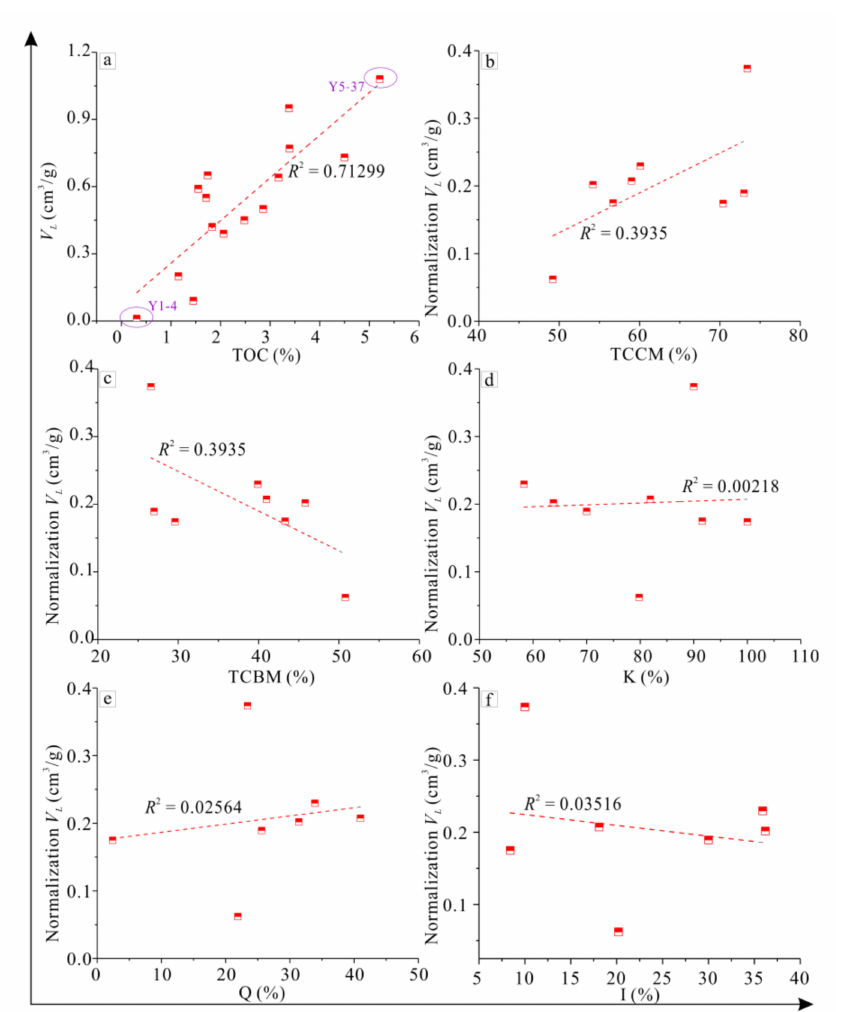
Figure 5. The correlation of V L versus TOC and mineral composition, where V L is the Langmuir volume and normalization V L is the V L normalized by the TOC value. ( a ) is the correlation of V L versus TOC, ( b ) is the correlation of V L versus TCCM, ( c ) is the correlation of V L versus TCBM, ( d ) is the correlation of V L versus kaolinite, ( e ) is the correlation of V L versus quartz and ( f ) is the correlation of V L versus